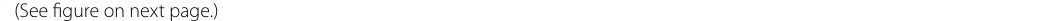
figure on next Fig. 2 Conidia germination rate and sclerotium production of FluS and FluR isolates of B. cinerea . The conidia germination rate of FluS and FluR isolates incubated at 25 °C for 10 h on WA ( a ) and WA supplemented with 5 μg/mL fluxapyroxad ( of FluS and FluR isolates grown on PDA for 3 days at 25 °C and then incubated for 4 weeks at 10 °C. d Column diagram showing the amount of sclerotia of FluS and FluR isolates after incubation on PDA for 3 days at 25 °C and then for 4 weeks at 10 °C. For statistical analysis, bars denote standard errors of three repeated experiments. Values on bars followed by the same letter are not significantly different from each other at P